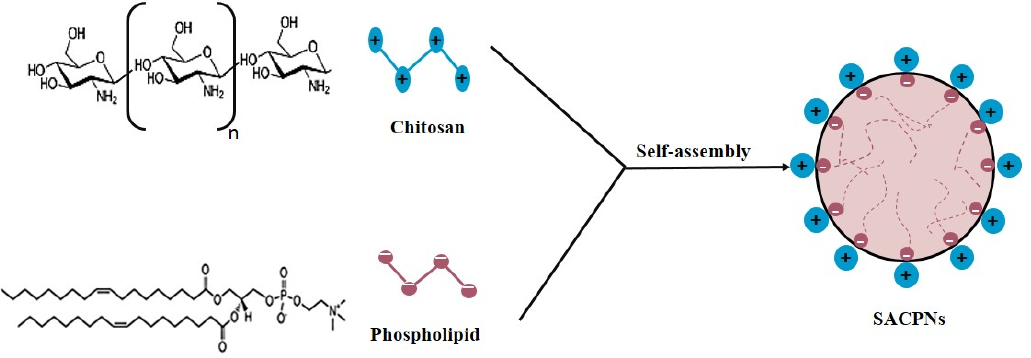
Figure 4. Schematic illustration of the interaction between chitosan and phospholipid, and the SACPNs self-assembly.